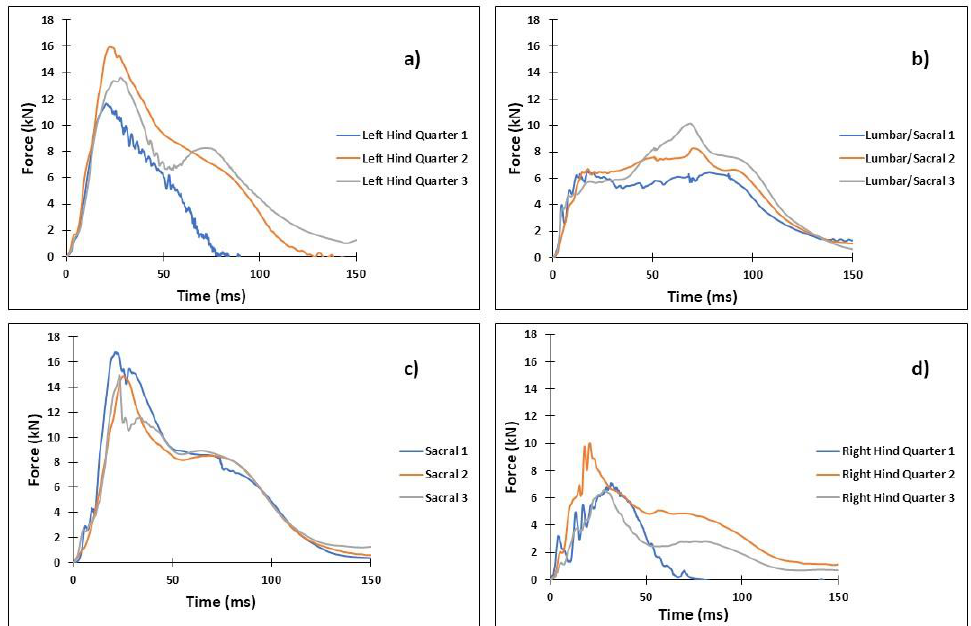
Figure 5. Un-helmeted drop test force–time history plots for horse 1. ( a ) Left hind quarter impact location. ( b ) Lumbosacral vertebrae junction impact location. ( c ) Sacral vertebrae impact location. ( d ) Right hind quarter impact location. Table 1. Un-helmeted drop test results for horse